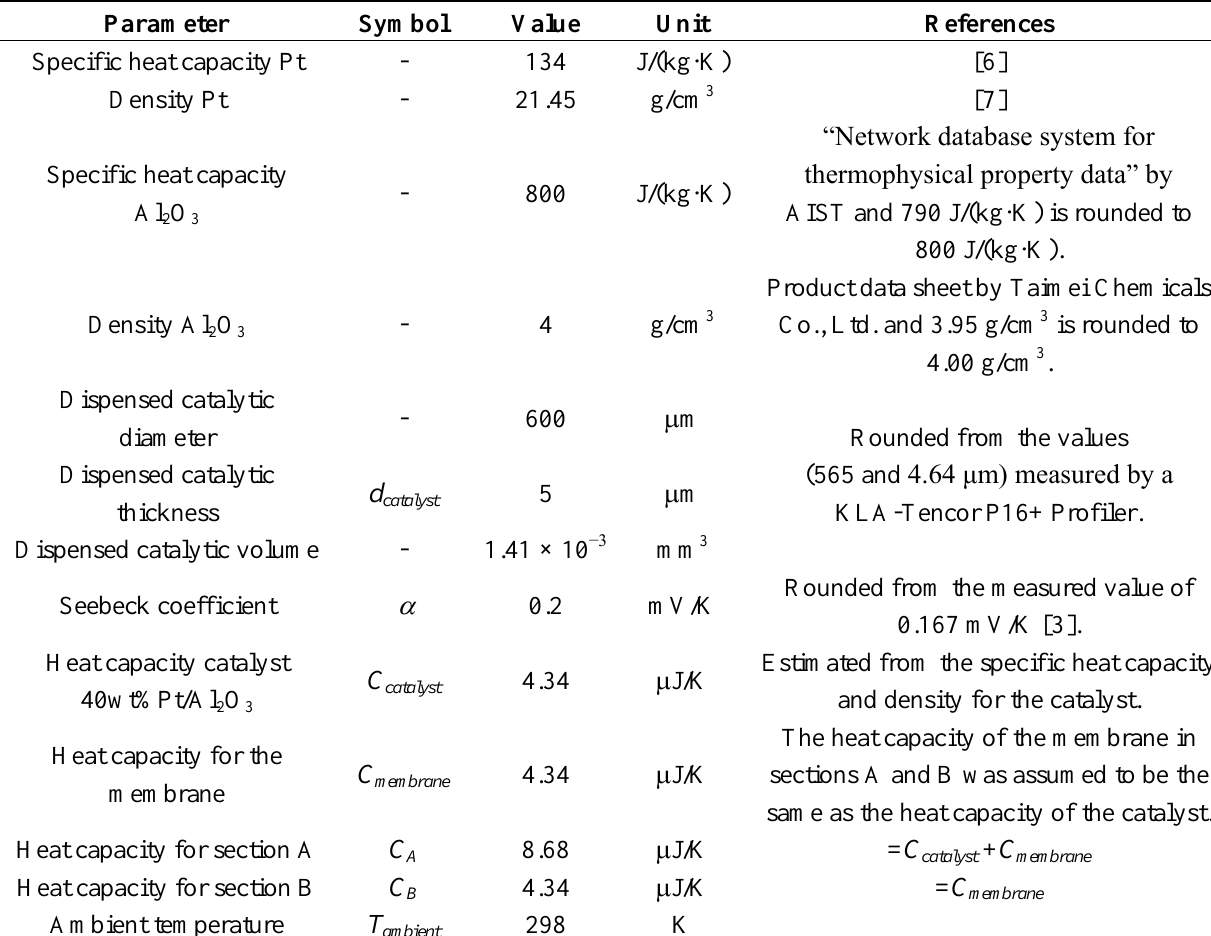
Table 1. Material constants and boundary conditions for the TGS used in this study.